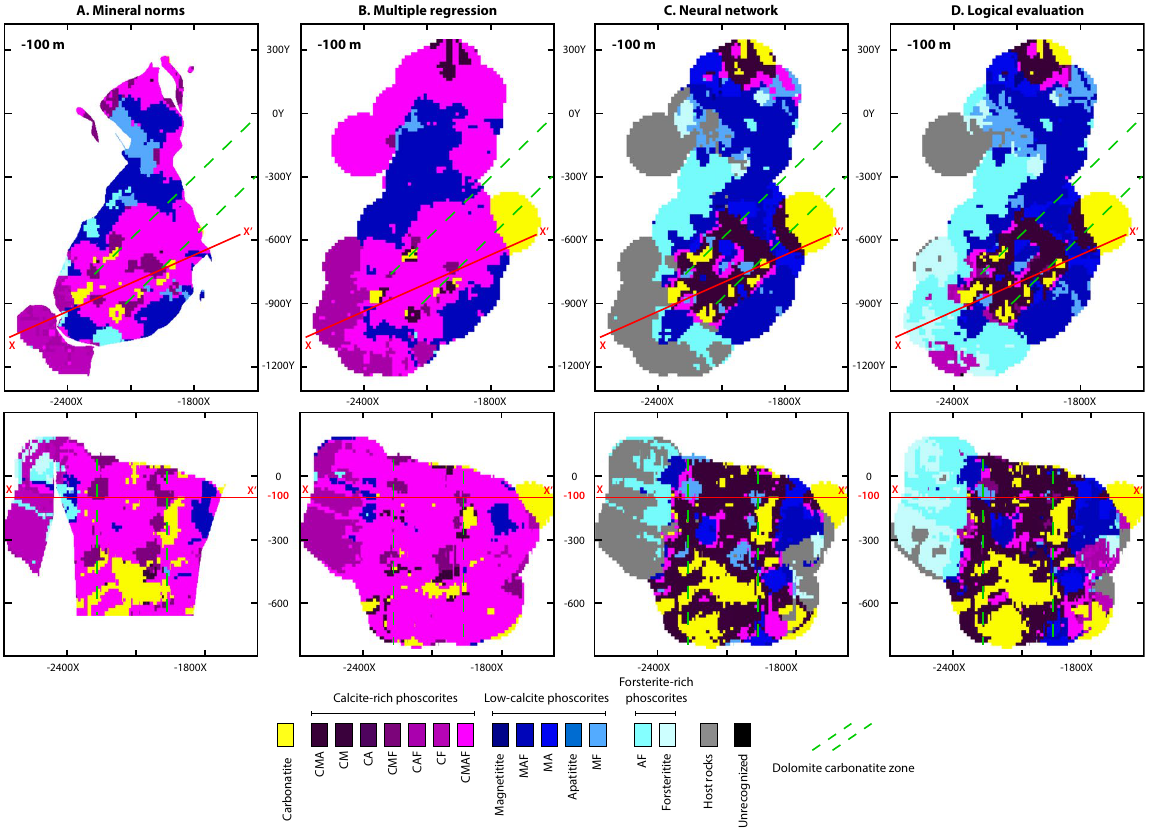
Figure 6. 3D geological models of the Kovdor deposit automatically built by different methods from drillcore bulk-rock chemistry: ( A ) – by calculations of mineral norms; ( B ) – by multiple regression; ( C ) – by artificial neural network; ( D ) – by logical evaluation. Horizontal section − 100 m (top) and cross-section X–X’. Red lines – location of sections. Green dashed line is the zone of dolomite carbonatite veins (Fig. 7). The 3D models were generated by Micromine 2016, commercial license